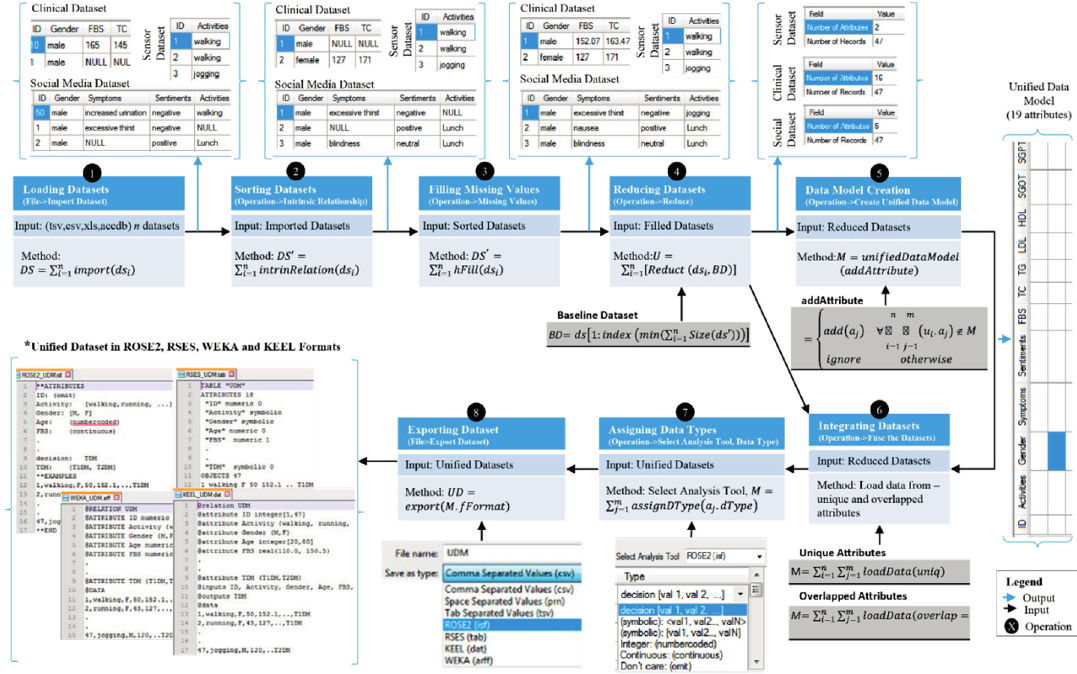
Figure 5. Working of the “data modeler” to create unified dataset in diabetes